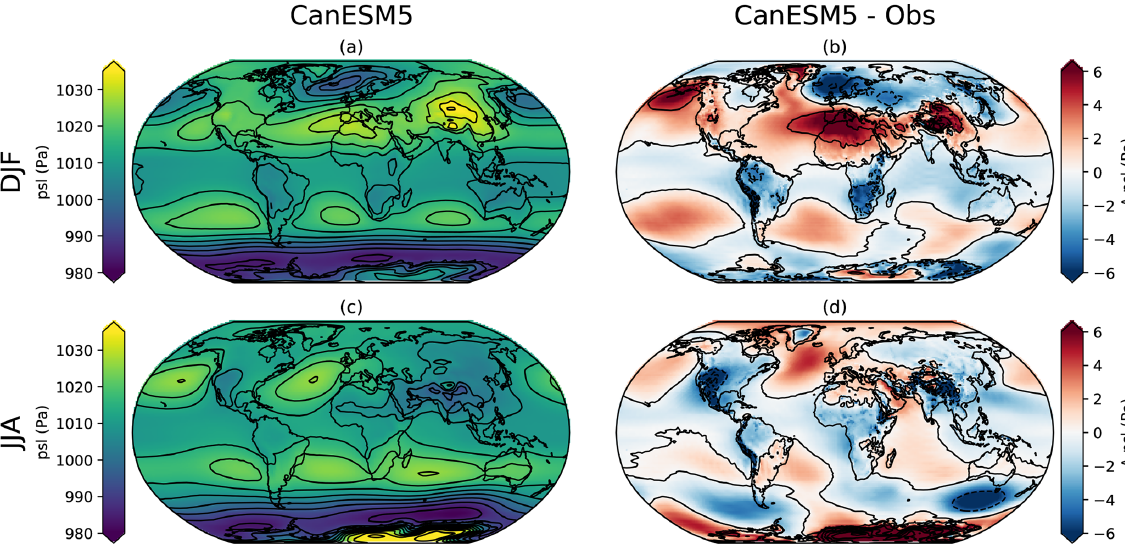
Figure 7. Climatologies of sea-level pressure over 1981 to 2010 in CanESM5 (a, c) and their bias from ERA5 over the same period (b, d) shown for the DJF (a, b) and JJA (c, d) seasons.